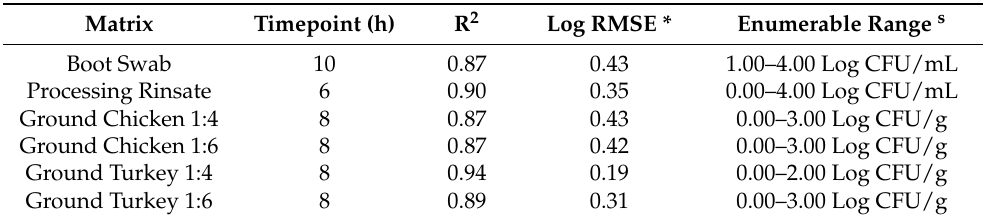
Table 1. Curve Development Parameters for Boot Swab, Processing Rinsates, Ground Chicken, and Ground Turkey Matrices.